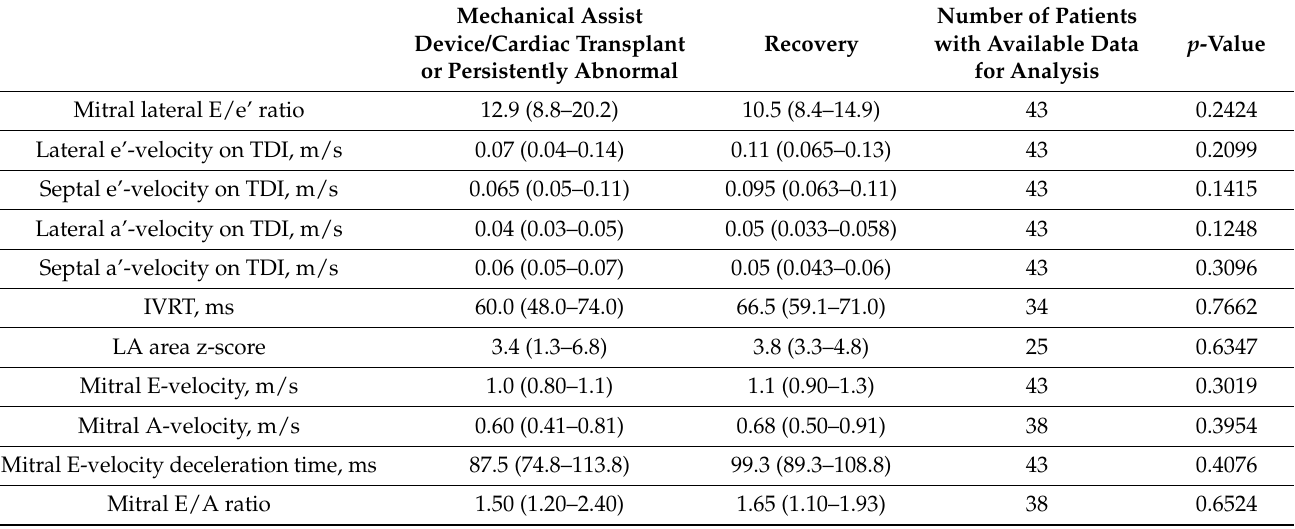
Table 3. Echocardiographic data for diastolic function. Data are presented as median and interquartile range